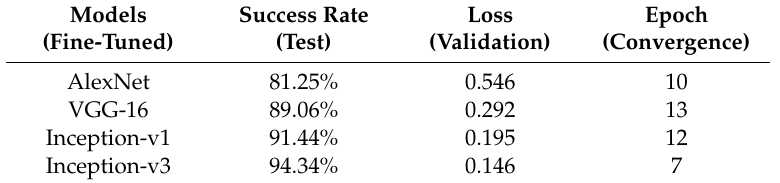
Table 3. Performance of various CNNs newly trained on the dataset with data augmentation.